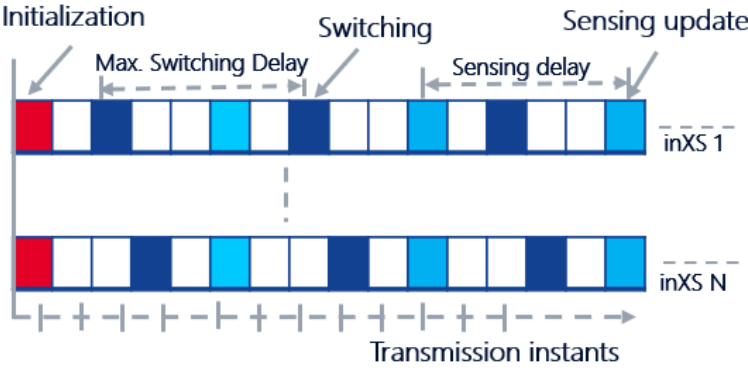
Figure 3. Sensing measurement updates and resource selection with both maximum switching delay and sensing delay equal to 5. InXSs 1 and N are assigned random switching integers 2 and 3, respectively. At initialization, all inXs perform random resource selection.